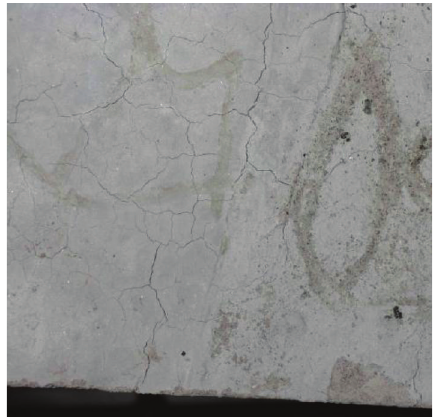
Figure 4: Microcracks on specimen surface (600 ∘